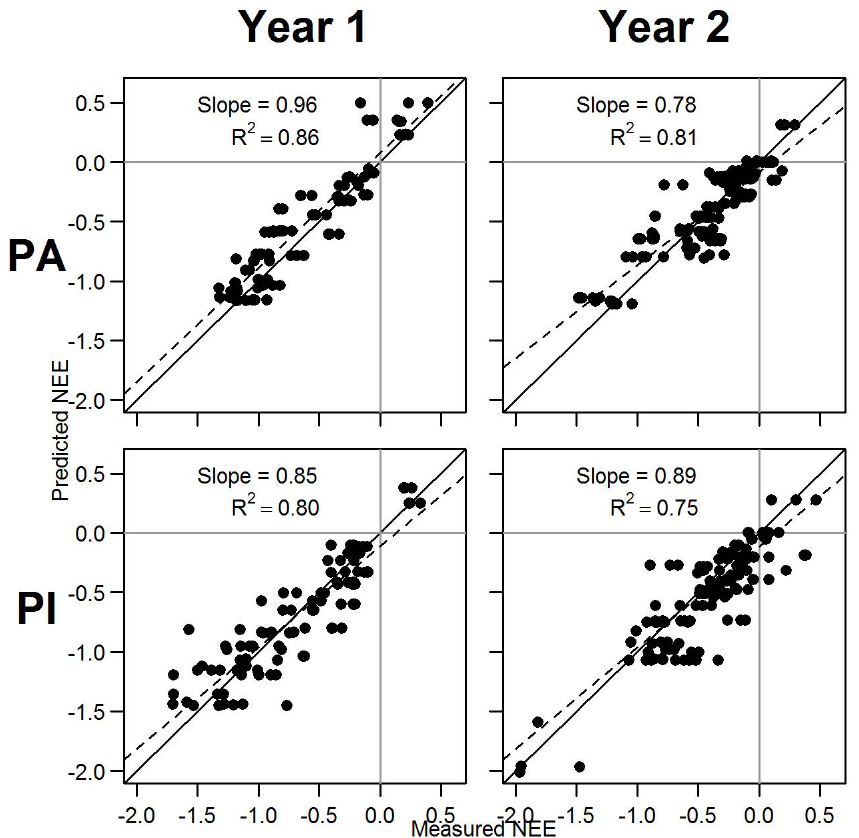
Figure 5. Modelled against measured NEE fluxes (g m -2 h -1 ) for S. palustre (PA) and S. papillosum (PI) together with a linear regression (dashed line) and 1:1 line (solid line). “Year 1” corresponds to the period from September 2011 to August 2012 and “Year 2” to the period from September 2012 to August 2013. The slope and R 2 of the linear regression fit are also